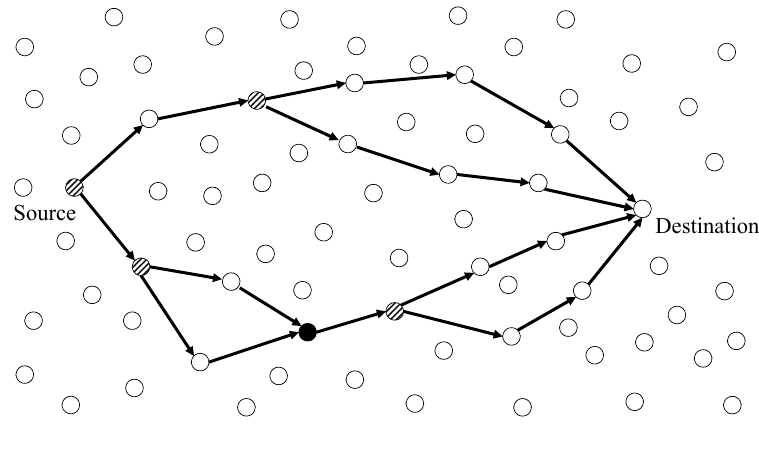
Figure 1. An overview of the opportunistic mulitpath routing protocol.